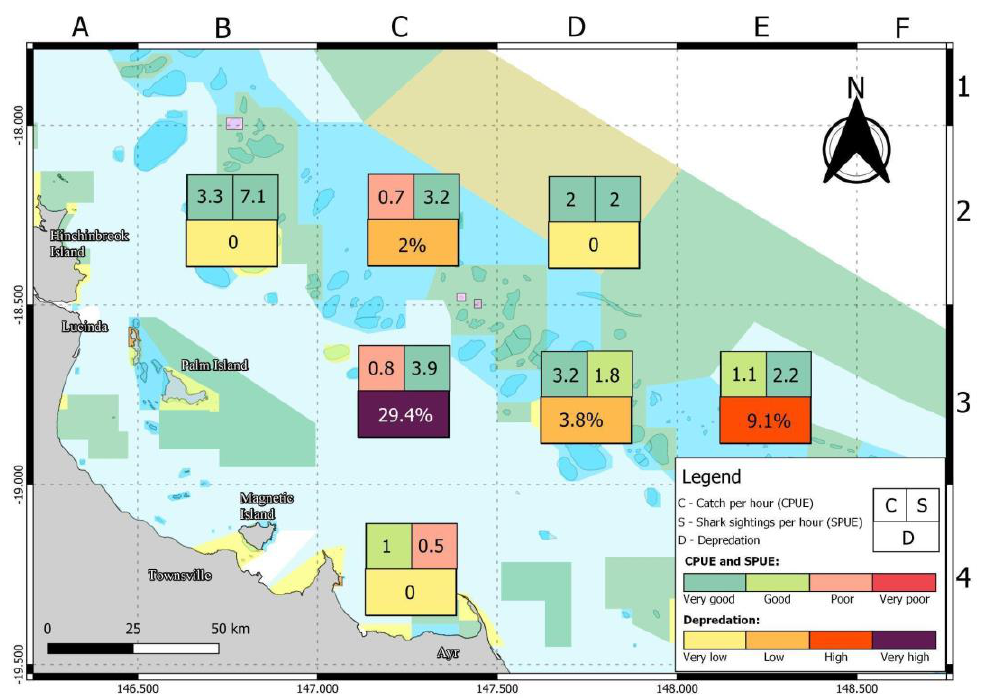
Figure 8. Average catch of fish and sightings of sharks per hour by survey unit area and assessment of status of fish catch, shark numbers and depredation (see Table 2 for key). Grid letters A–F and numbers 1-4 are used to label locations of NQBI competition.